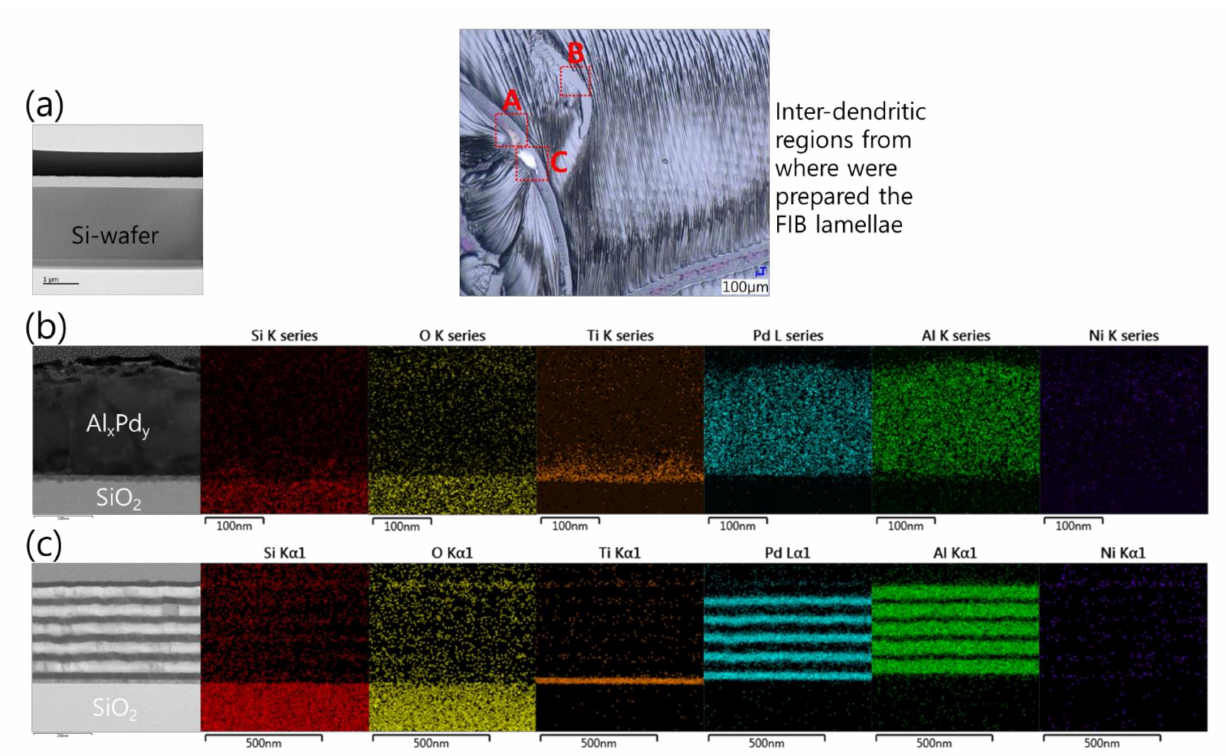
Figure 20. TEM cross section images and EDS analyses performed on different FIB cross sections selected from different regions of the upper surface of the reacted Pd/Al-Ni/Al MS-iRMS (see the inset optical microscopic image). ( a ) FIB cross section from a bare inter-dendritic area (zone A); ( b ) FIB cross section from a region where a partial reacted product was detached (zone B); ( c ) FIB cross section from a region where a partial unreacted multilayer stack residue was still attached to the substrate (zone